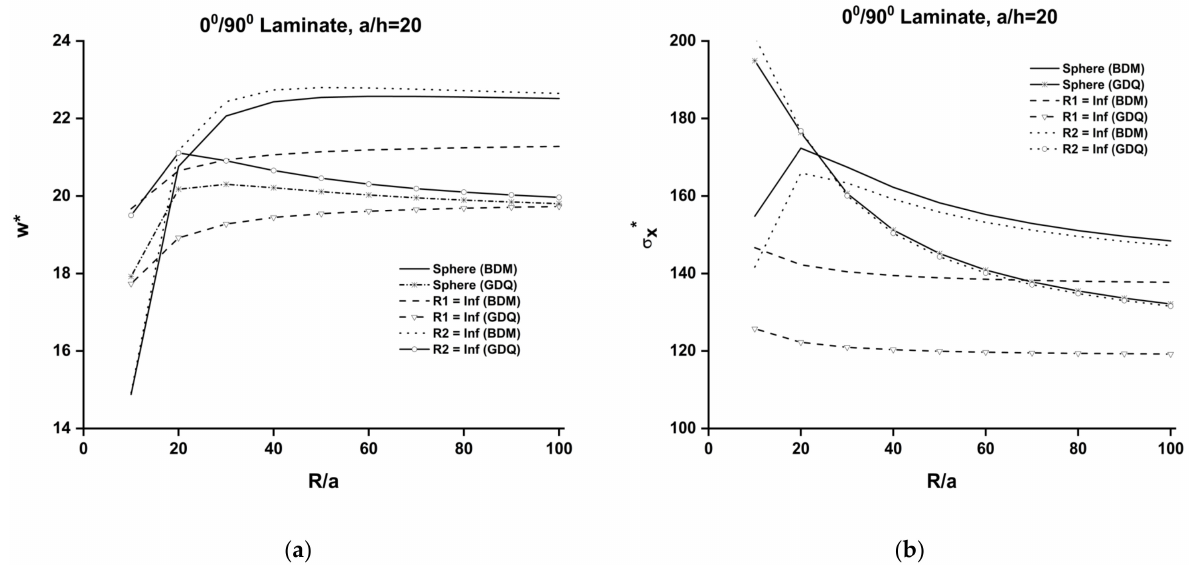
Figure 4. ( a ) Variation of non-dimensional displacement, w ∗ , and ( b ) non-dimensional stresses, σ x ∗ , with the a / h ratio for symmetric [0 ◦ /90 ◦ /0 ◦ ] spherical and cylindrical panels (R/ a = 10).